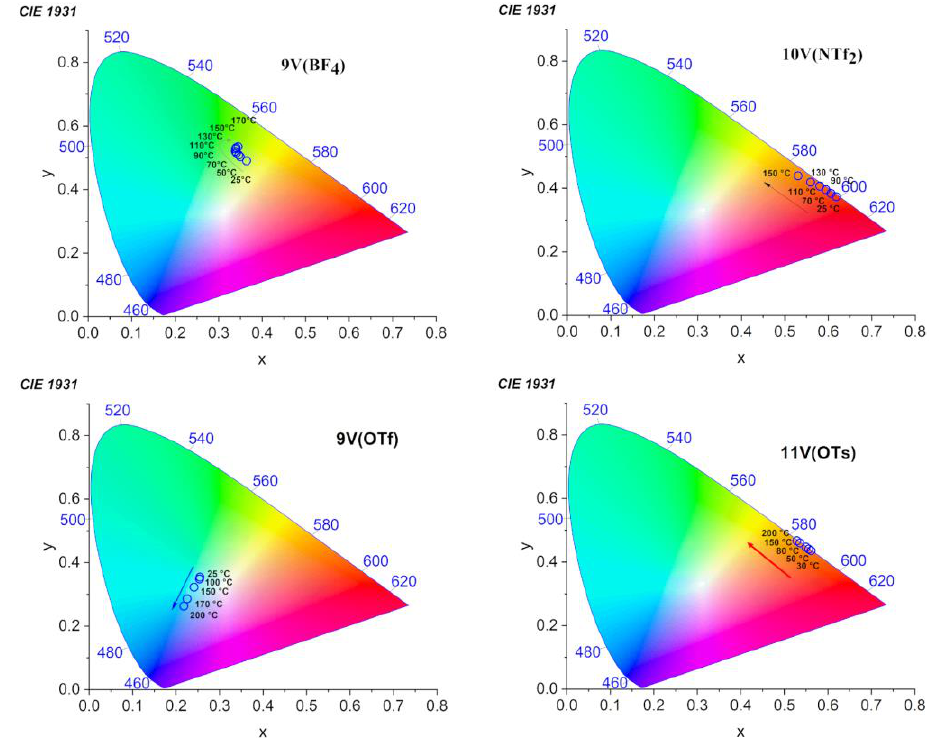
Table 3. Thermofluorochromic behavior of mVX compounds: characteristic colors and CIE coordinates for each phase.